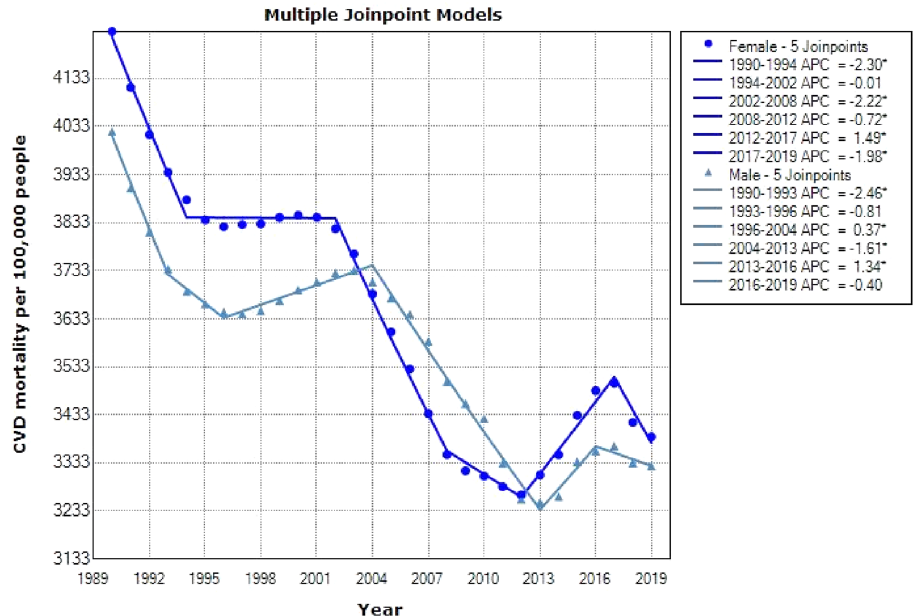
Figure 4. Joinpoint regression model for CVD mortality aged +70 by gender: 1990–2019.